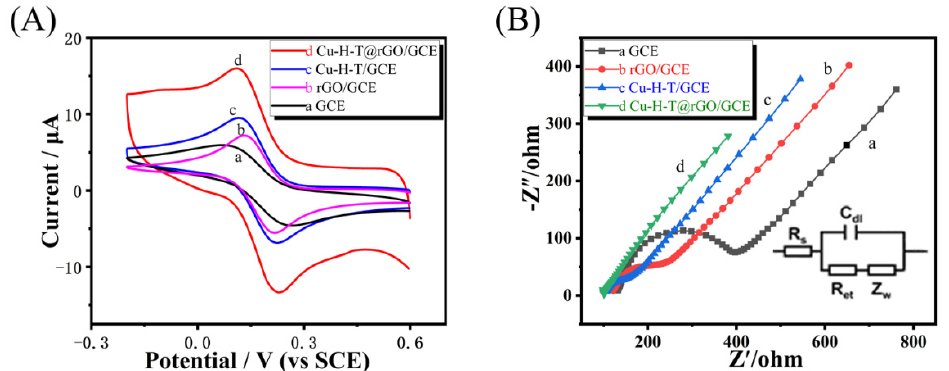
Figure 3. ( A ) CV and ( B ) Nyquist plots of bare GCE, rGO/GCE, Cu-H-T/GCE, and Cu-H-T@rGO/GCE recorded in 5 mmol · L − 1 [Fe(CN) 6 ] 3 − /4 − containing 0.1 mol · L − 1 of KCl. The insert in ( B ) shows an equivalent circuit diagram applied to fit the Nyquist plots quantitatively.